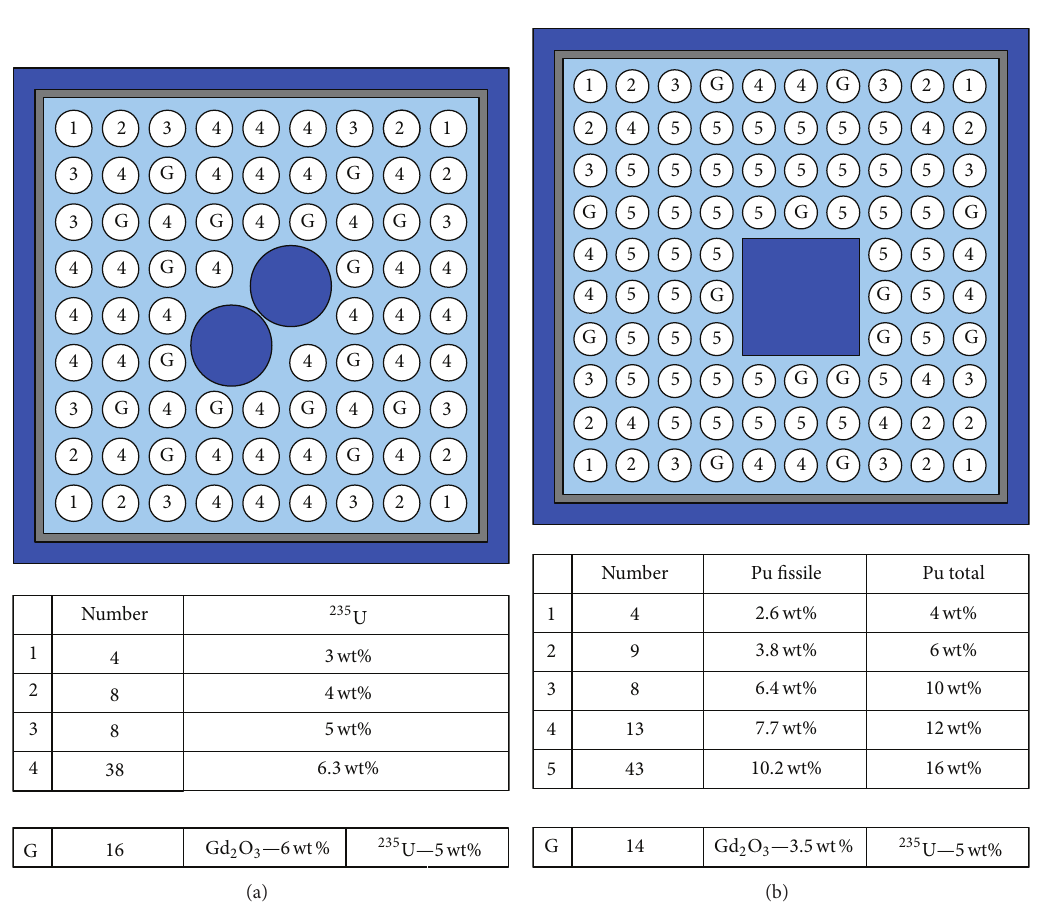
Figure 2: Innovative BWR assemblies designs with UO 2 fuel (a) and MOX fuel